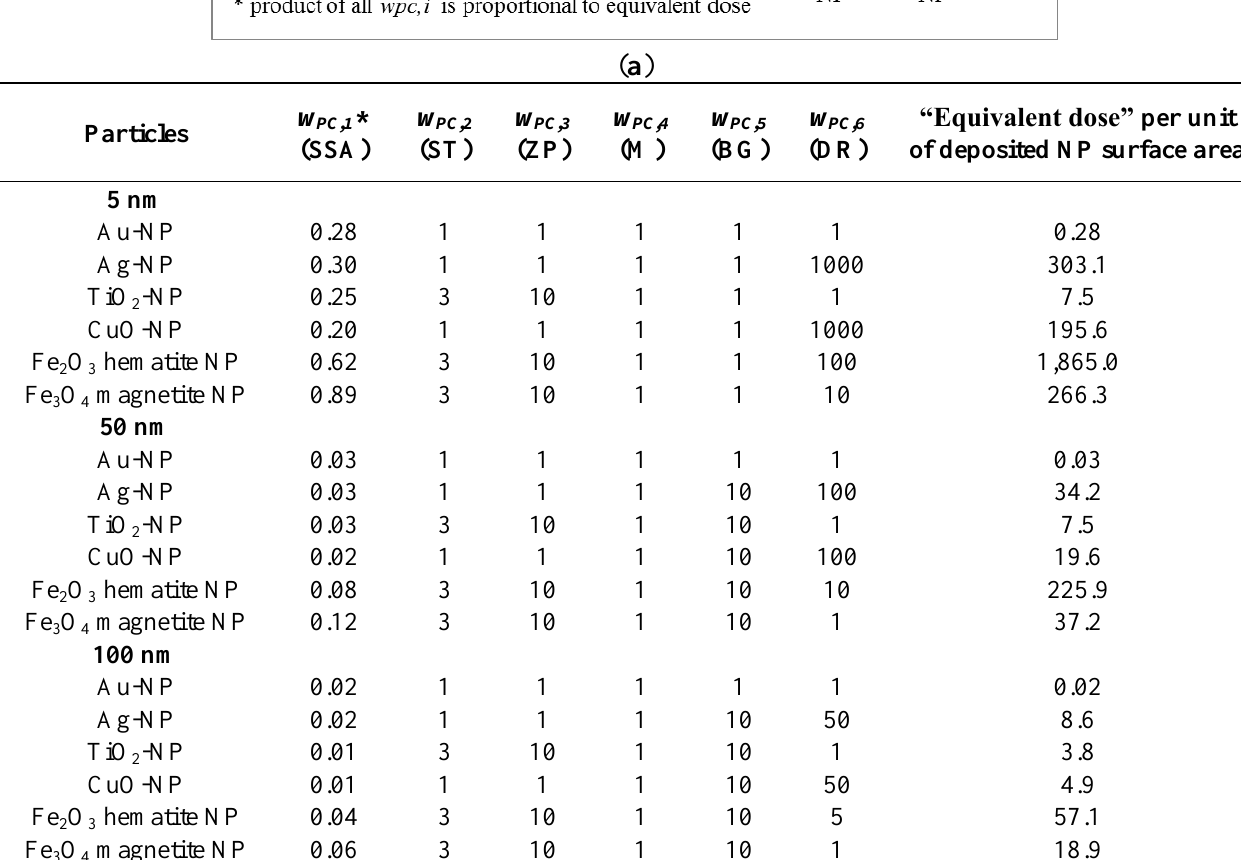
Figure 1. SSA: specific surface area; ST: surface textures; ZT: zeta-potential; M: morphology; BG: bend gap energy level; DR: dissolution